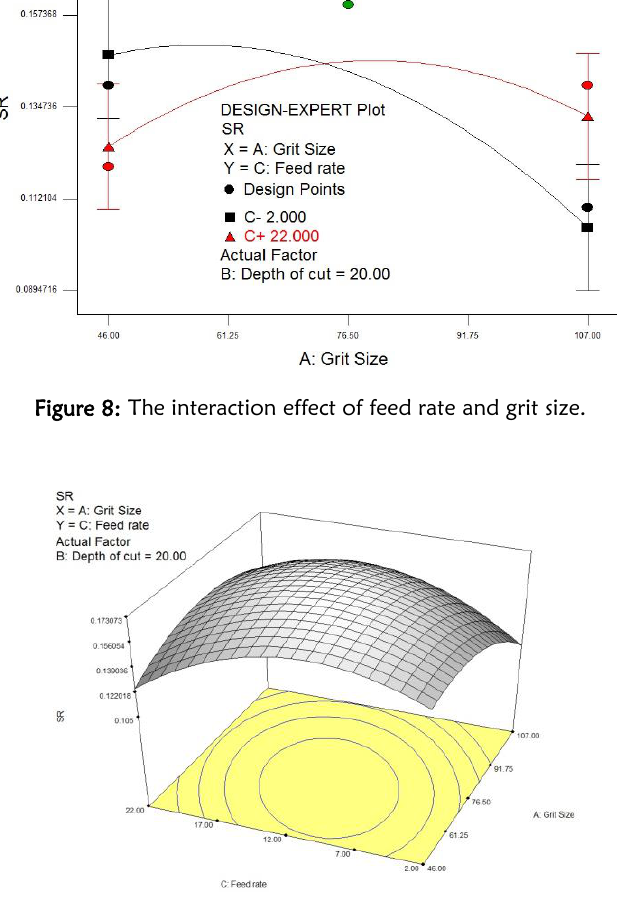
Figure 9: The 3D plot of the interaction effect of feed rate and grit